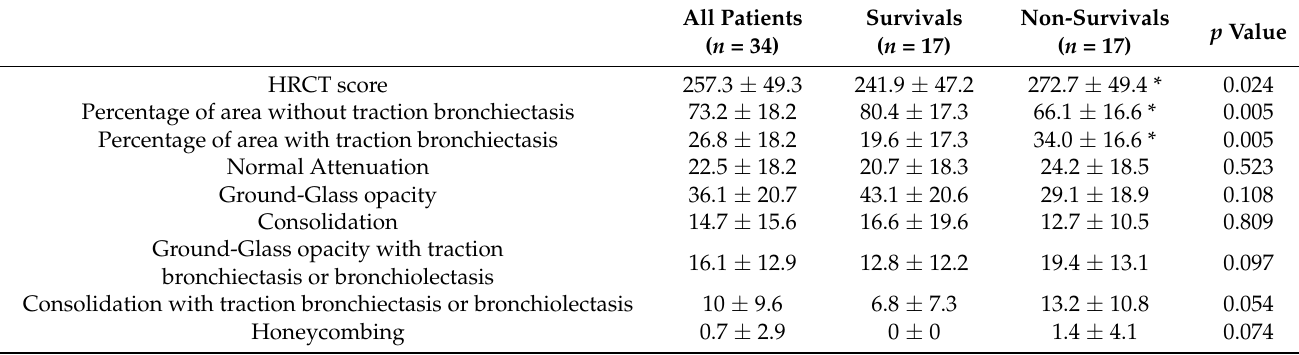
Table 2. HRCT score and HRCT findings of survivors and